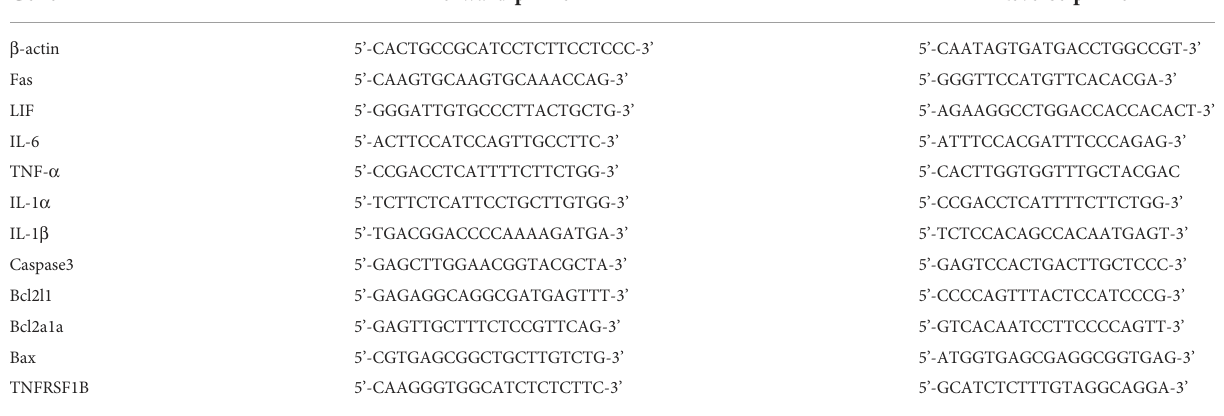
TABLE 1 Mice Primer Sequences for